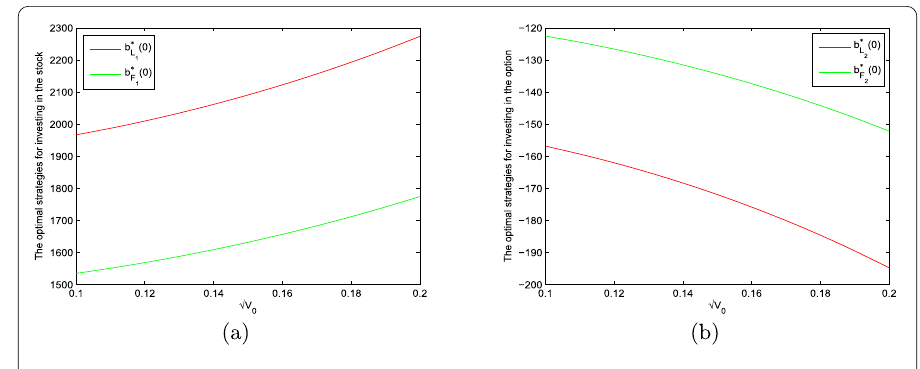
Figure 6 Sensitivities of optimal investment strategies to volatility